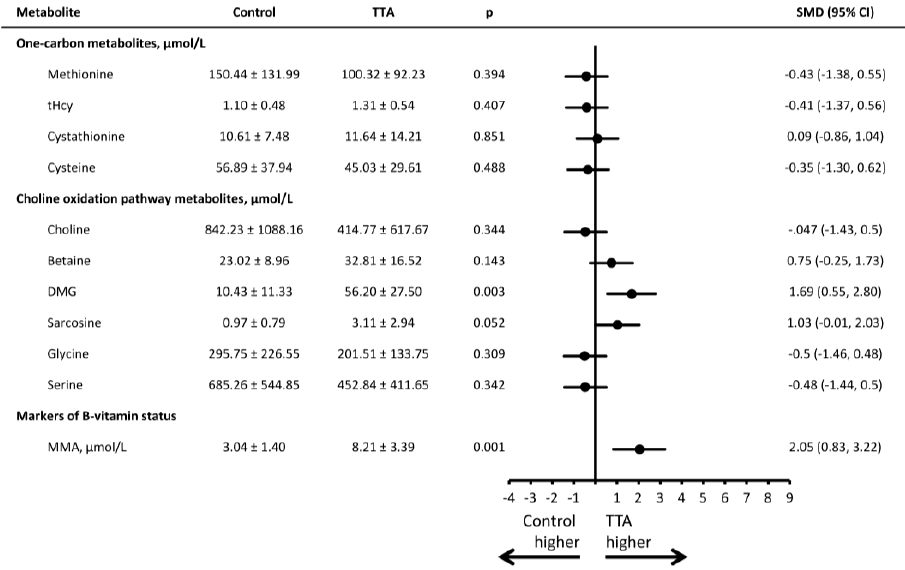
Figure 3. Urinary concentrations of metabolites in rats receiving a high fat control diet or a high fat diet with additional TTA treatment. Male Wistar rats were treated with a high-fat diet with or without additional TTA treatment, n = 10 in each group. Mean (SD) urinary concentration of the metabolites, as well as the standardized mean difference (95% CI) between the control and the TTA treated animals. DMG indicates dimethylglycine; MMA, methylmalonic acid; SMD, standardized mean difference; tHcy, total homocysteine; TTA, tetradecylthioacetic acid.